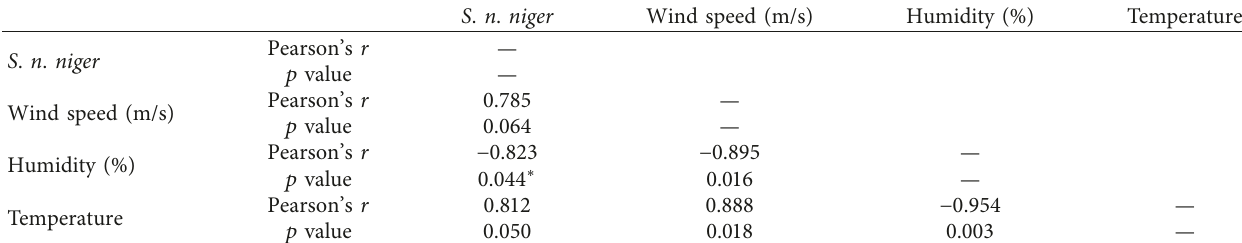
Table 6: Correlation matrix of daily ADT of S . n. niger with weather